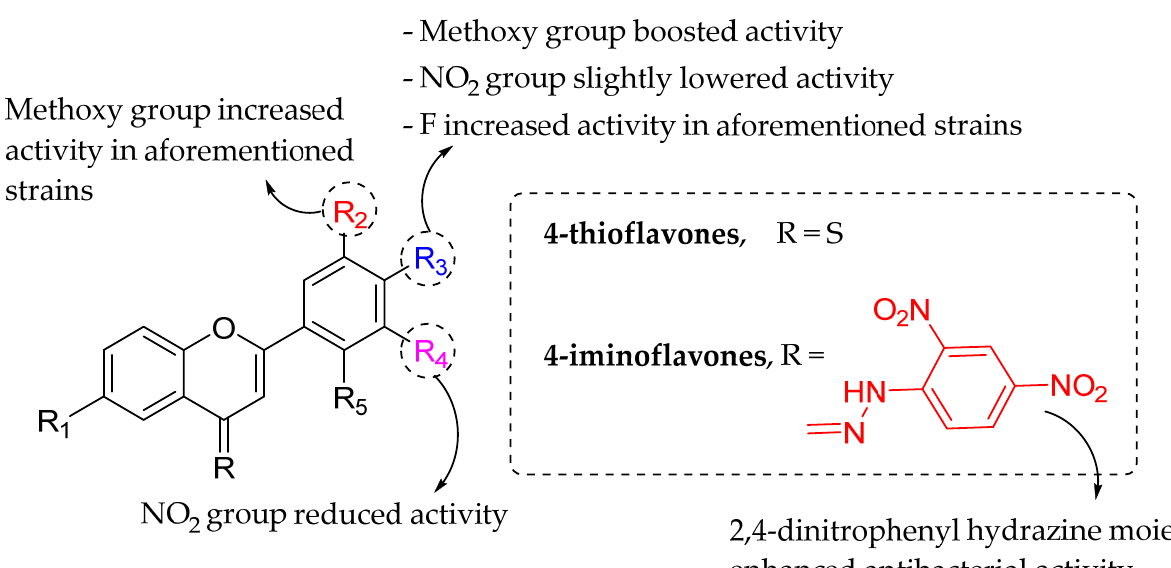
Figure 8. The structural-activity analysis of 4-thioflavones and 4-iminoflavones [75]. Echeverría et al. (2017) tested eight flavonoids (three flavanones and five flavones) for their antibacterial activity against four Gram-positive ( B. cereus , B. subtilis , Bacillus coagulans , and S. aureus ) and four Gram-negative ( Enterobacter cloacae , E. coli , Klebsiella pneumoniae , and Proteus mirabilis ) bacteria. The antibacterial activities are displayed in Table 5. It can be seen that flavones were more active against Gram-positive bacterial inhibition compared to flavanones. Therefore, it can be concluded that C2=C3 double bond may be essential for inhibiting bacterial growth. In flavanones, the